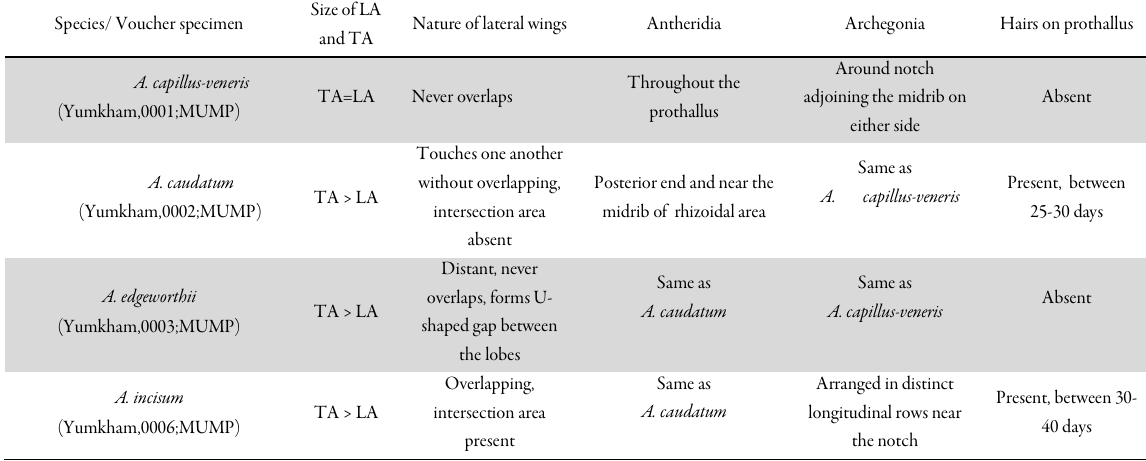
Table 1. Comparative account on gametophytes of four species of Adiantum Species/ Voucher specimen